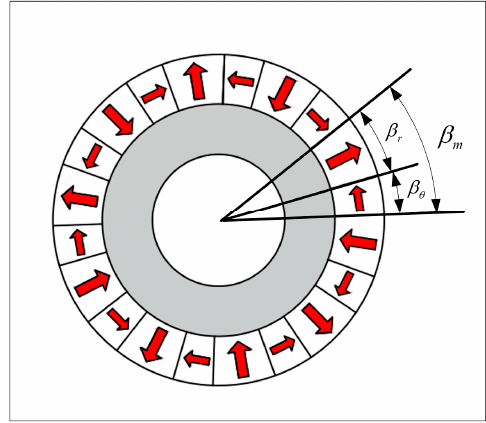
Figure 4. Halbach Array Magnet Ring.